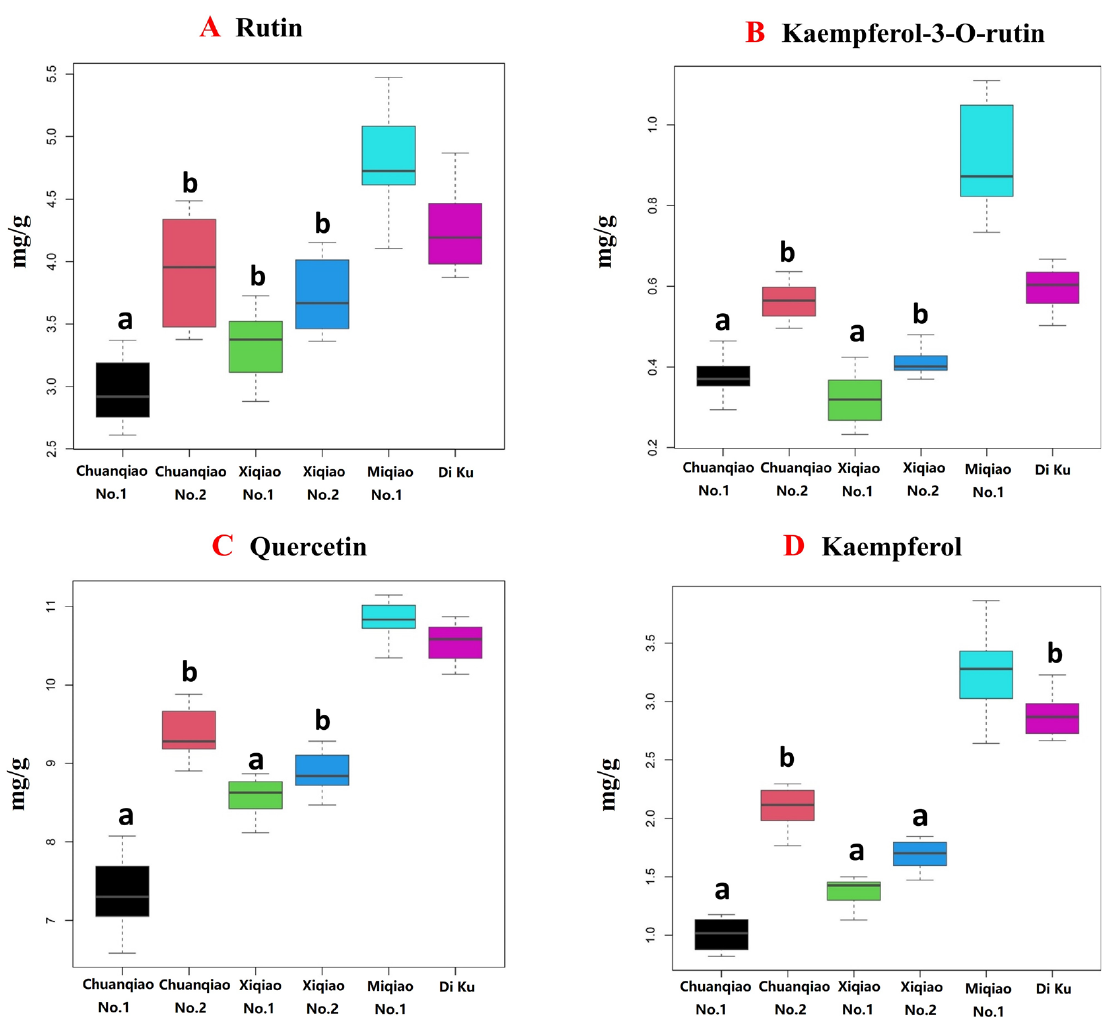
Figure 4. Box plot of contents of four flavonoids in different varieties of Tartary buckwheat. ( A–D ) contents of rutin, kaempferol-3-O-rutin glycoside, quercetin and kaempferol in six varieties of Tar-